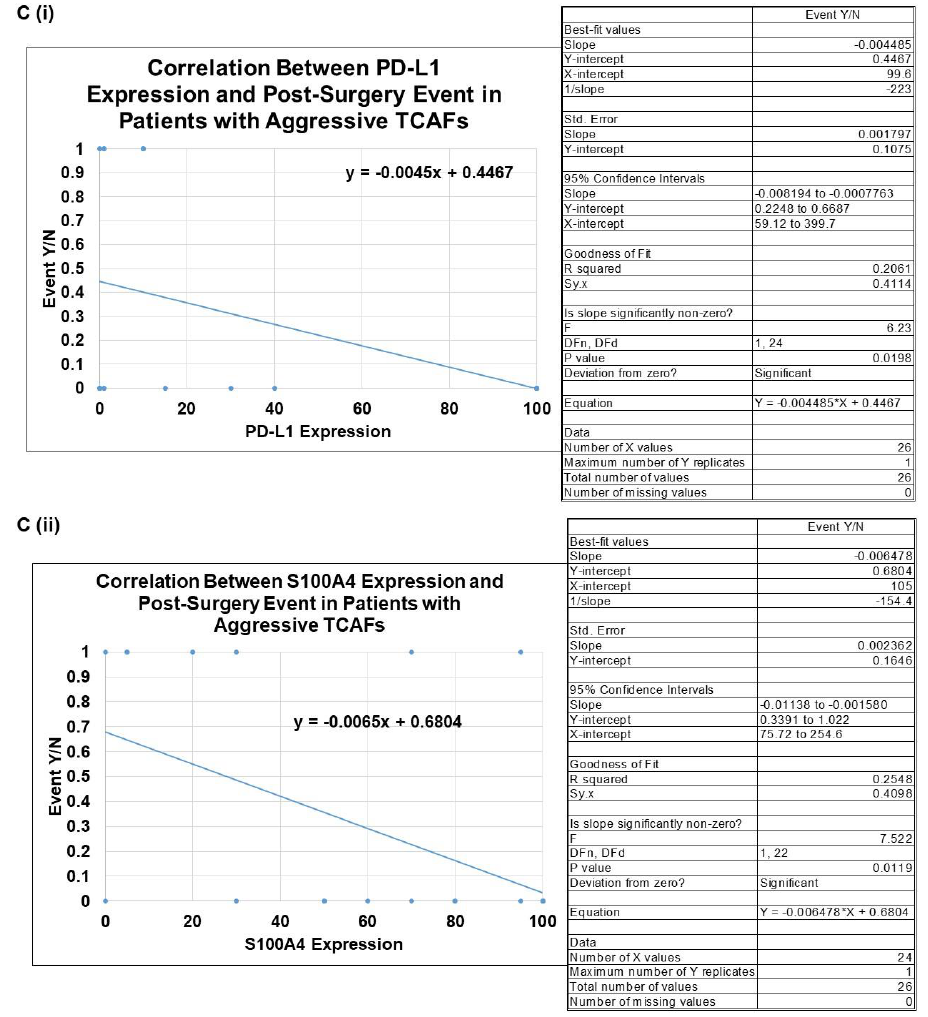
Figure 4. Pearson correlation between aggressive primary CAFs from patients with high grade (Grade 3)/high stage (Stage III/IV) of disease as well as the relationship between % of ICC expression of PD-L1 and S100A4 in aggressive TCAFs and a post-surgery event: Trendline showing the Pearson correlation (95% Confidence Intervals) between aggressive CAFs from patients with high grade (Grade 3) disease and a post-Surgery event. p = 0.0250 ( A ( i )). Trendline showing the Pearson correlation (95% Confidence Intervals) between aggressive CAFs from patients with higher stage (Stage III/IV) disease and a post-Surgery event. p = 0.0106 ( A ( ii )). n = 43 (Created using GraphPad Prism Version 9.4.1) ( A ). A heatmap of ICC % expression of TCAF markers of the aggressive CAFs sorted by events and no-events is presented ( B ). A correlation between % expression PD-L1 in the aggressive TCAFs and events ( C ( i )) and a correlation between % expression S100A4 in the aggressive TCAFs and events (C(ii)) are presented ( C ). We presented the aggressiveness by (present or absent) and the PSE by (PSE recorded by Sept. 2022 designated as “ Yes ” or No PSE recorded by Sept. 2022 as “ No ” ) to binary states. Several points overlap because the patient data are the same (for example, we have many patients who were both aggressive CAF and high grade, but it only shows one point on the graph because they share the exact same XY coordinate).